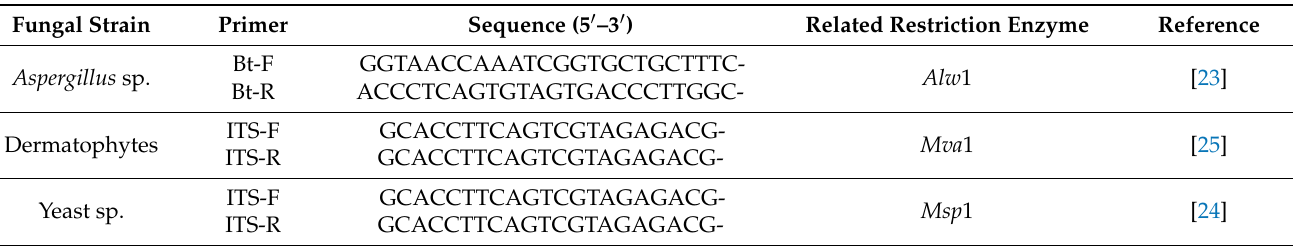
Table 1. Sequences of primers used in this